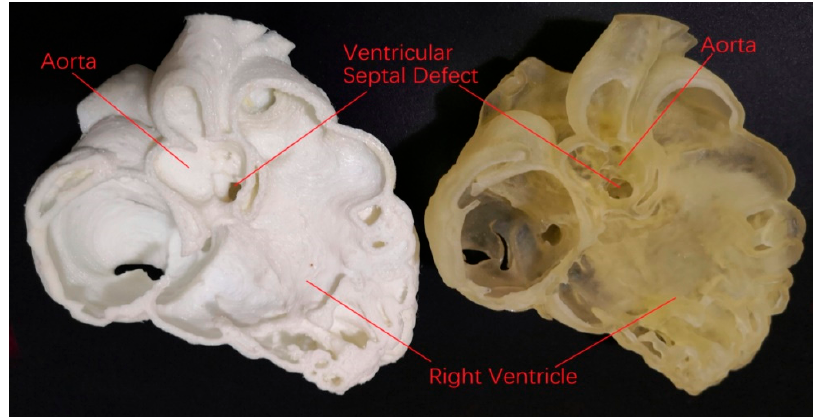
Figure 9. Comparison of low-cost (left image) with high-cost (right image) 3D printed heart model with similar accuracy in delineating cardiac anatomy and ventricular septal defect.